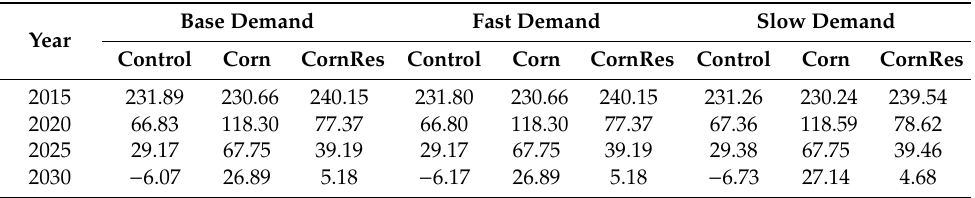
Table 6. Average GHG emissions projection (million ton per CO2e) during 2015 to 2030 under various biofuel policy and demand growth scenarios.